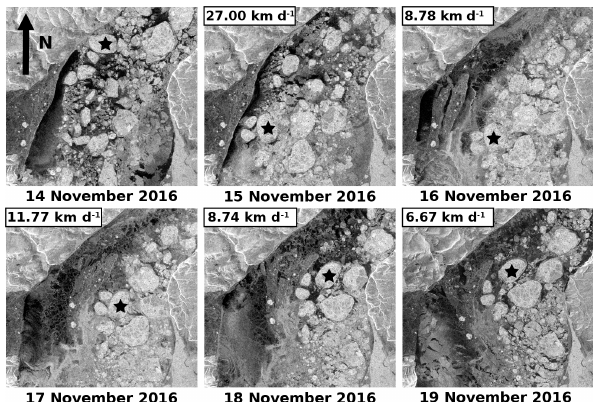
Table 3. Results from the multivariate regression analysis showing the contributions of wind and ocean current to ice floe motion. Parameter Standardized coeff. Statistical significance Pearson corr. coeff. Partial corr. coeff. Intercept < 0.001 Wind speed Current speed